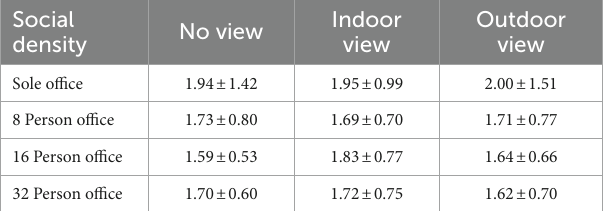
TABLE 1 Mean and standard deviations of estimated personal space (measured in m 2 ) within the virtual environment across view type and social density for the Korean